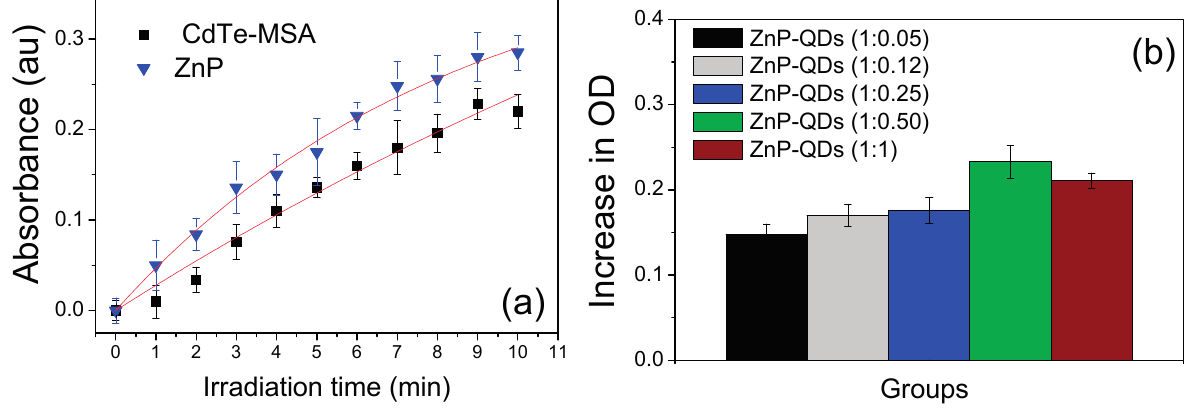
Figure 5. Indirect detection of ROS generation monitored by the increase in optical density (OD) at 580 nm (NBT oxidation). ( a ) Generation of ROS upon irradiation of ZnP (blue triangles, R 2 = 0.997) and CdTe-MSA QDs (black squares, R 2 = 0.965 ([PS] = 1 µmol·L − 1 ) and ( b ) ROS generation upon irradiation for 10 min of mixtures containing different proportions of ZnP and CdTe-MSA QDs. Analysis of variance (ANOVA) showed that the differences among the various molar fractions of QDs-ZnP conjugates were significant ( p <